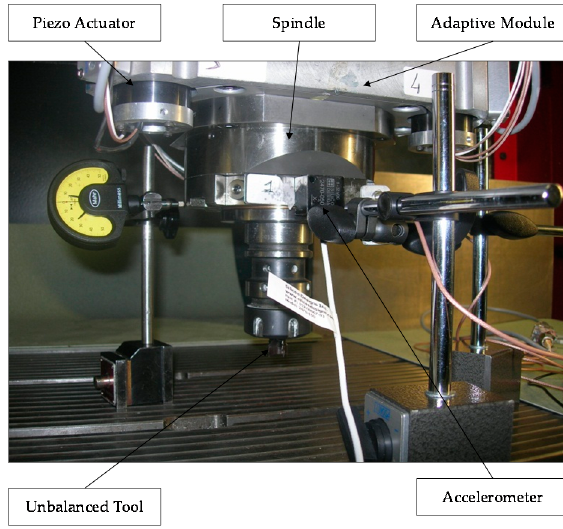
Figure 8. Experimental test overview.